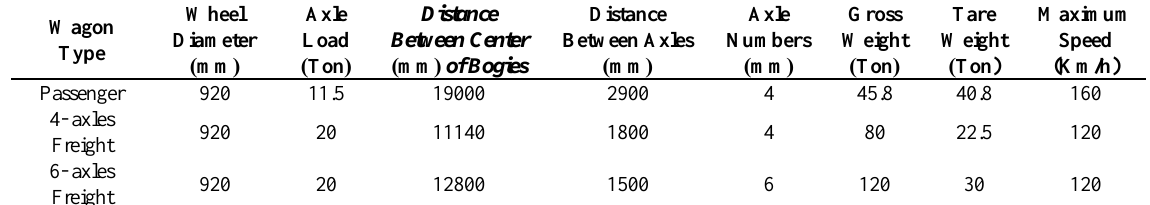
Fig.1. Schematic view of selected wagons. Table 1. Main characteristics of selected wagons.